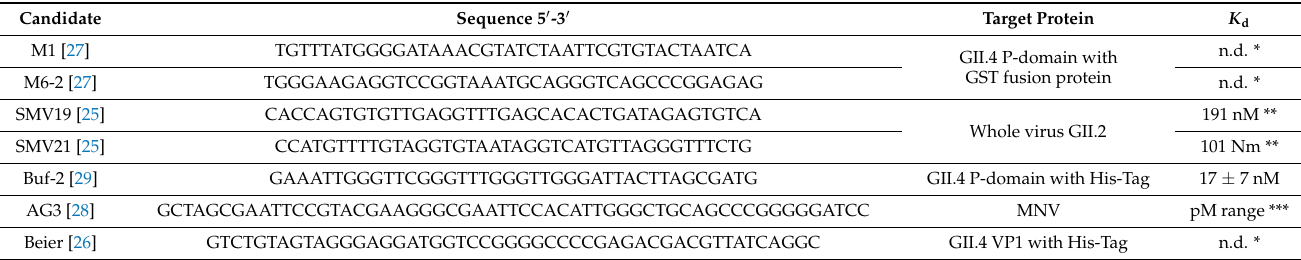
Table 1. Summary of selected, previously published norovirus aptamers, their SELEX target, and determined K d . Candidate Sequence 5 (cid:48) -3 (cid:48) Target Protein K